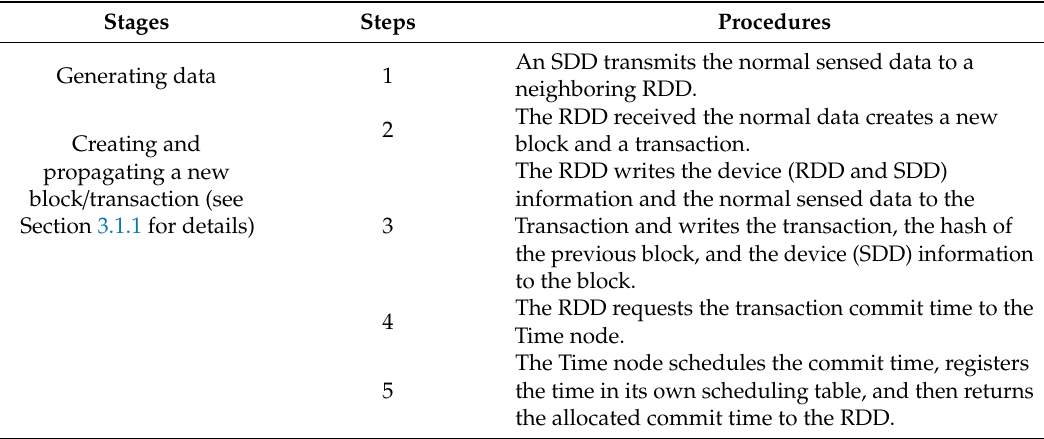
Table 1. The normal sensed data blockchain processing